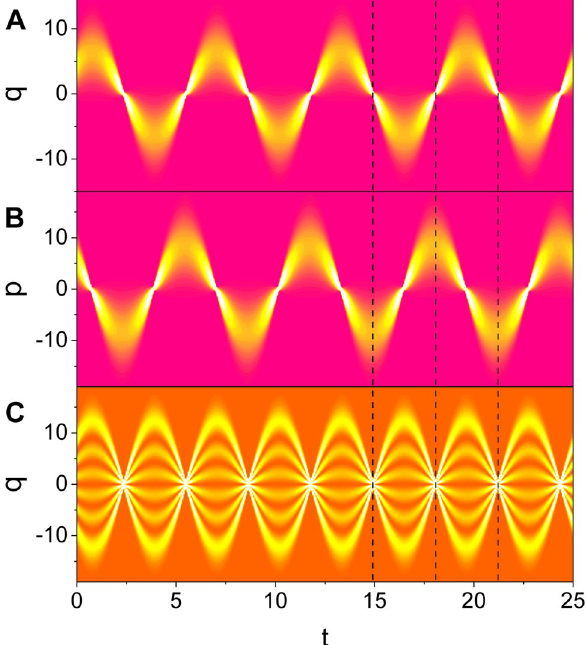
Figure 2. Comparison between time evolutions of different probability densities for nonstatic waves. ( A ) is 2 , ( B ) is 2 , and ( C ) is 2 where n (cid:31) n q A p A q |� | �| |� | �| |� | �| ǫ θ 0 , and ϕ 1 , t 0 0 . = = = =